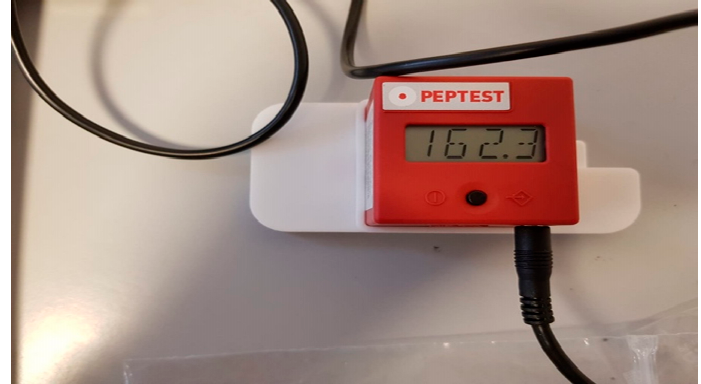
Figure 2. The PEP-test Cube: A small electronic device that displays the result of pepsin concentration analysis in different fluids directly in ng/mL.